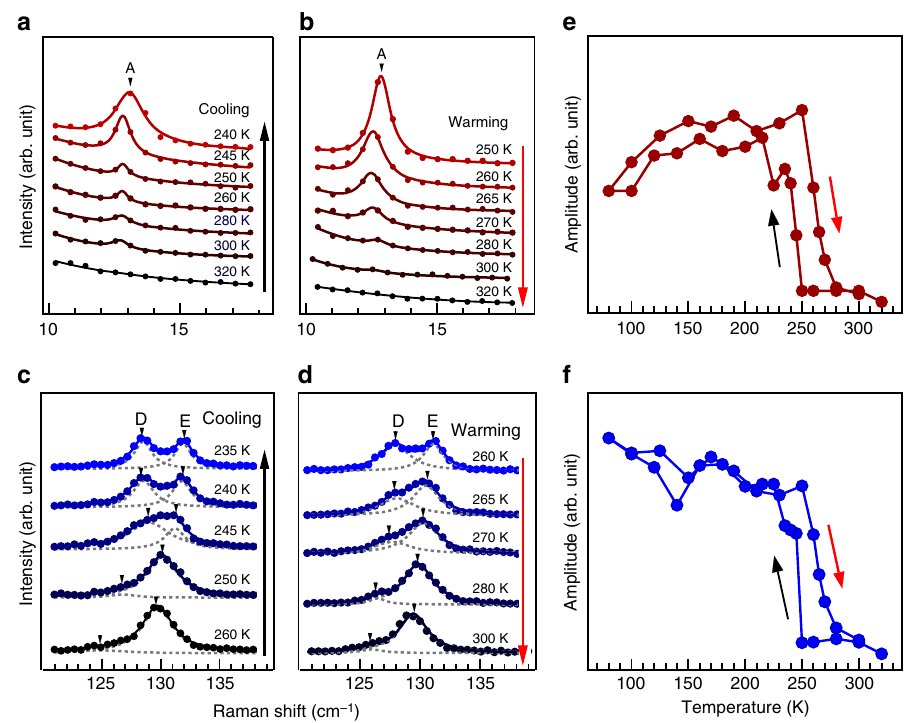
Figure 4 | Temperature dependence of the Raman spectra for peaks A and D in the aa configuration. ( a – d ) Selected Raman spectra across the phase transition for peaks A ( a , b ) and D ( c , d ) upon cooling ( a , c ) and warming ( b , d ). ( e , f ) Temperature dependence of the Raman intensity for peaks A and